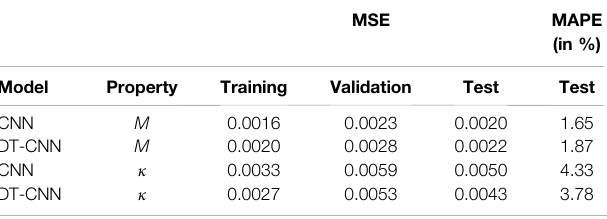
TABLE 6 | Error measures for the prediction of M and κ via ordinary CNN and DT-CNN where MSE is given for the training, validation and test sets, and MAPEforthetestset. NotethatMSEisevaluated on thelogitscalefor M and log scale for κ , and MAPE on the linear scale.